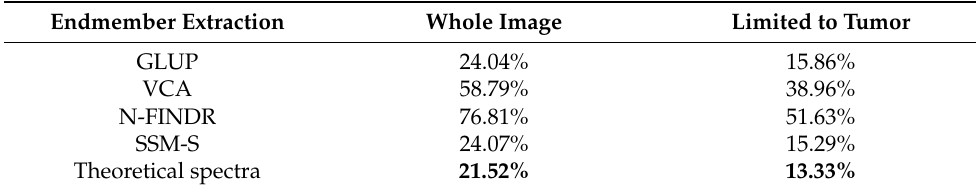
Table 1. Summary of the average sO 2 relative deviation values. The abundances are estimated using the FCLS